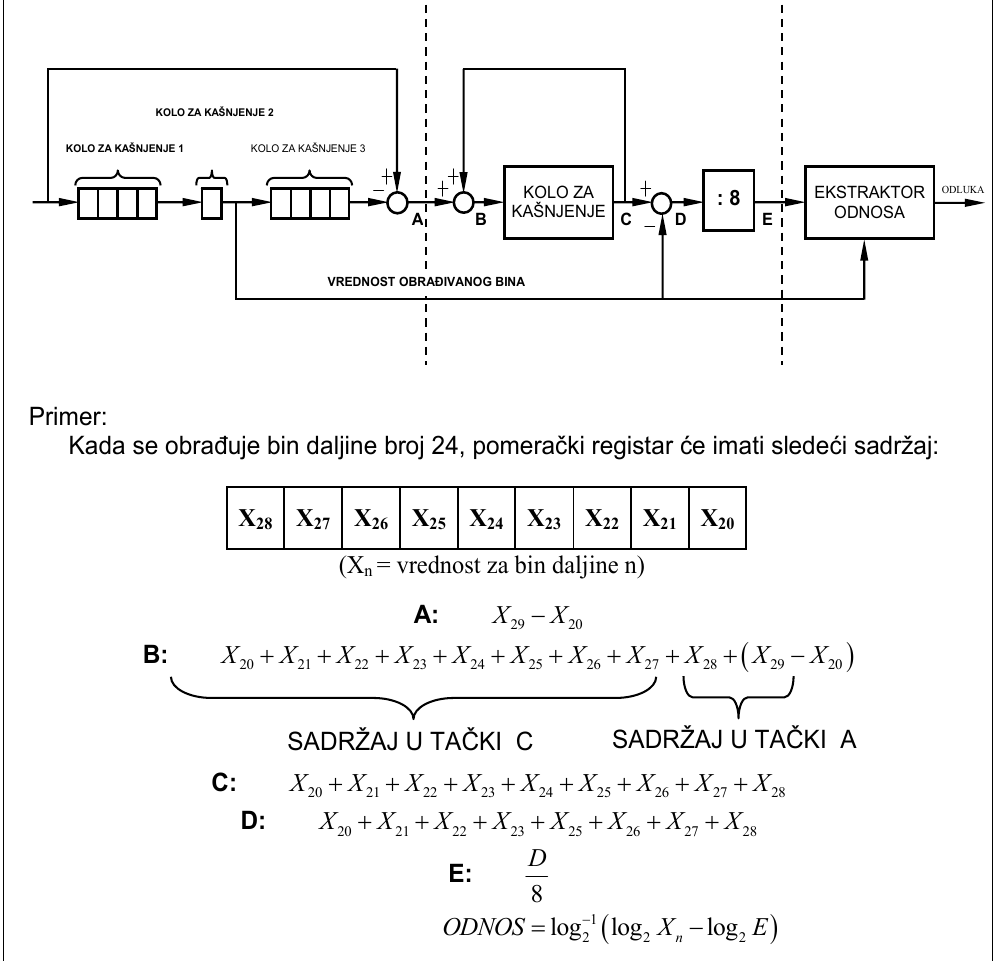
EKSTRAKTOR ODNOSA